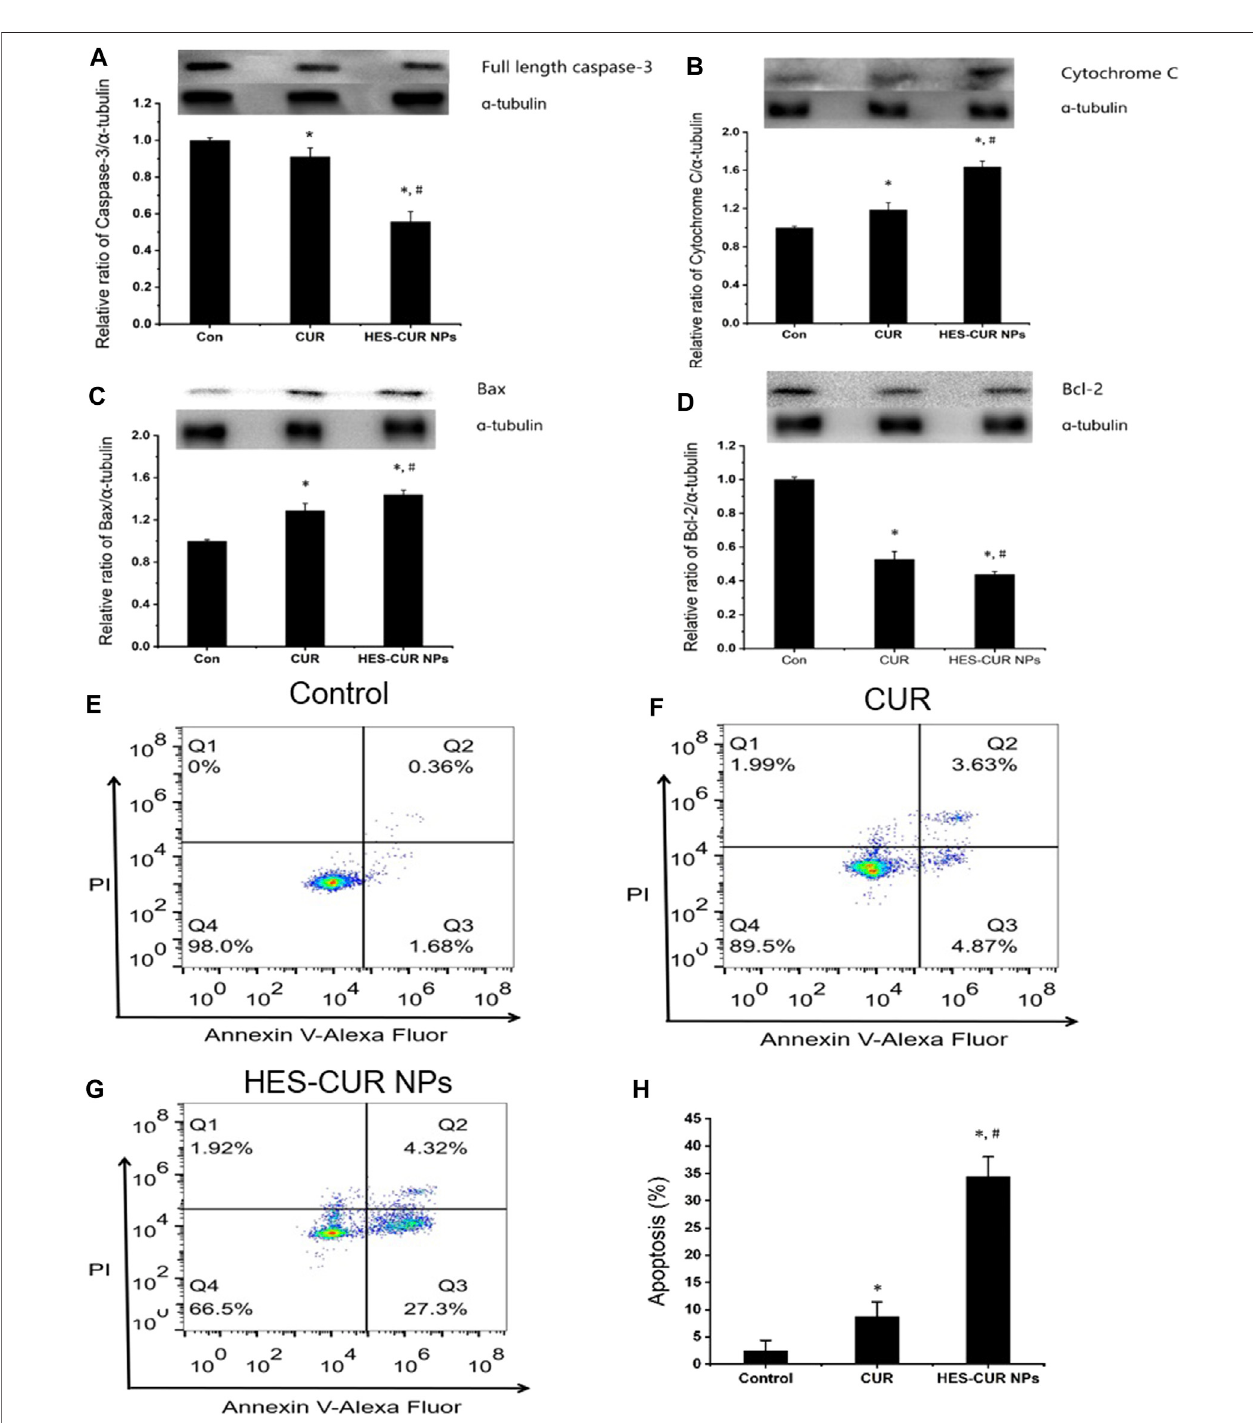
FIGURE 5 | Effects of CUR and HES-CUR NPs on HepG2 cell apoptosis. (A) Full length caspase-3, (B) cytochrome c, (C) Bax, and (D) Bcl-2 expression levels weredetectedusingWesternblot. (E – G) FlowcytometricresultsofHepG2cellsaftertreatingwithCURorHES-CURNPs.Q4 (cid:1) livecells,Q3 (cid:1) earlyapoptosis,Q2 (cid:1) late apoptosis,andQ1 (cid:1) necrosis. (H) HepG2cells weretreated withCURand HES-CUR NPs. Percentages ofapoptotic cellswerequanti fi edby fl owcytometry.Datawere expressed as mean ± SD, and the experiments were repeated thrice. * p < 0.05 indicated signi fi cant differences from the control group; # p < 0.05 indicated signi fi cant differences from the CUR